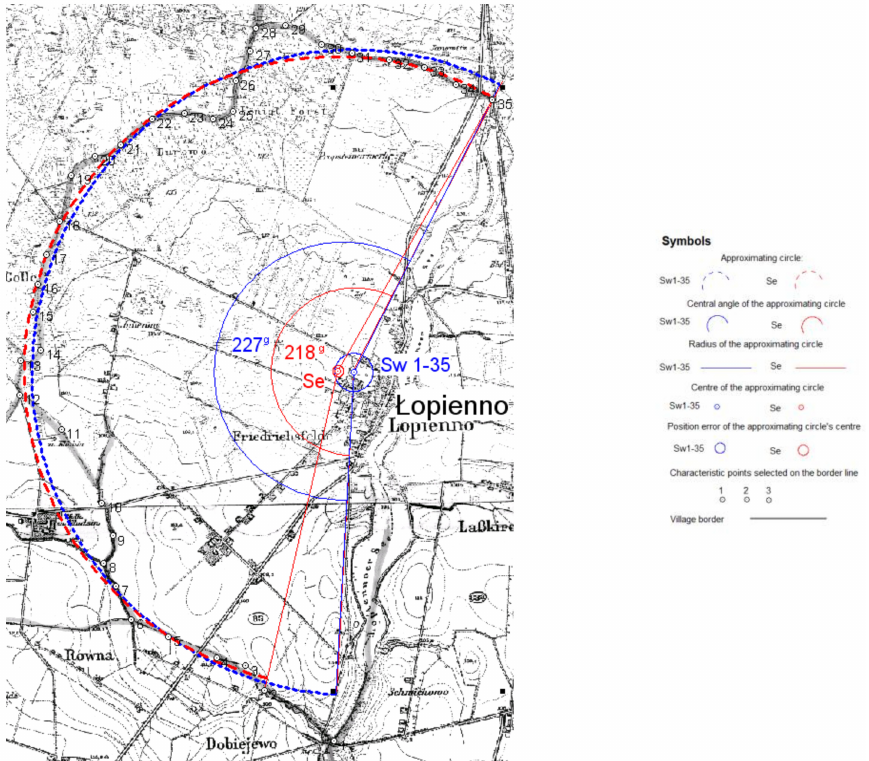
Figure 11. Łopienno. Course, position and error of the approximating circle: Sw 1—35— approximation of points 1—35, Se—approximation of points 2–35, without points 9–14, 19, 23–25, 27–30. Scale